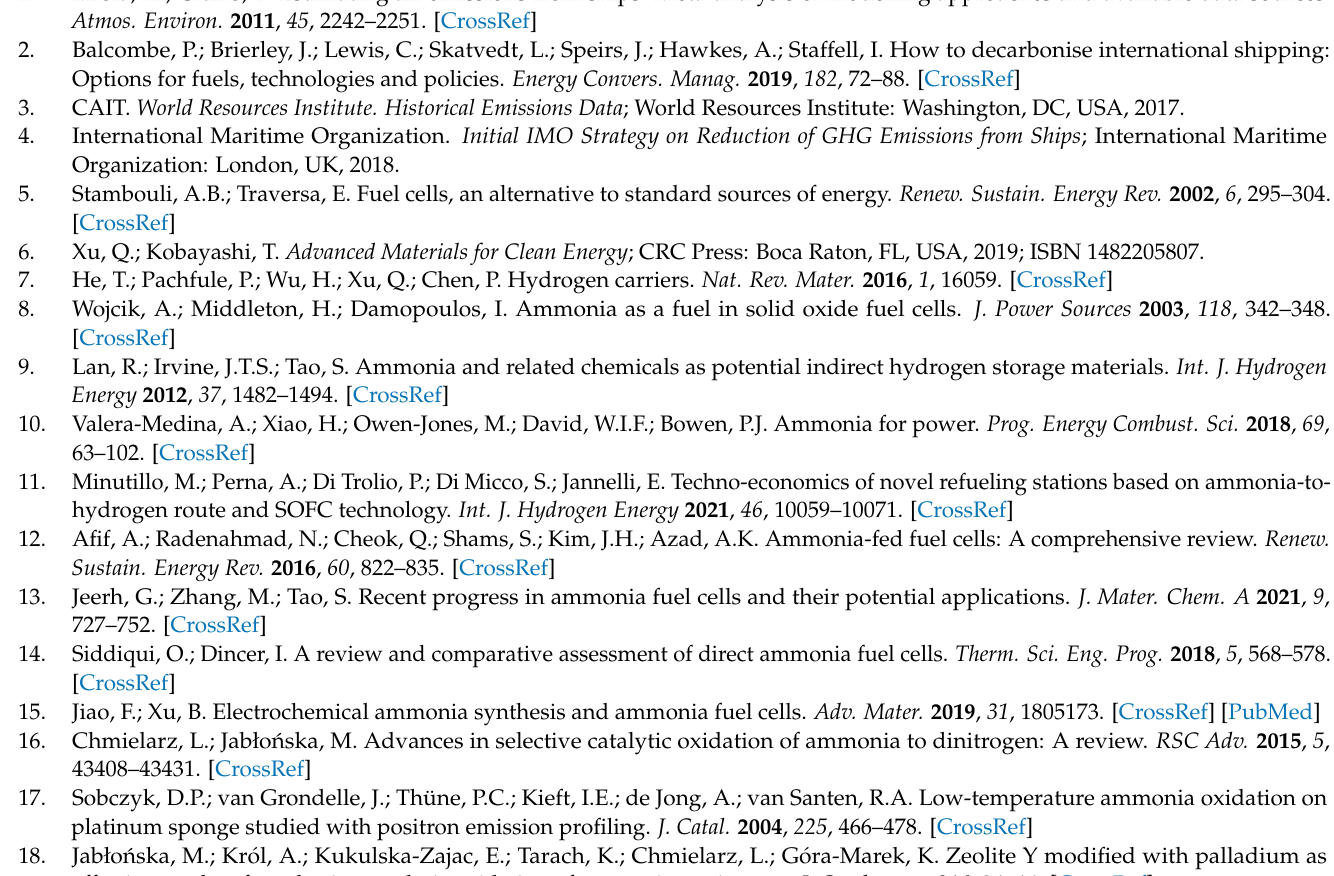
based catalysts; Figure S2: Powder XRD pattern of transition metal-based catalysts; Figure S3: TEM micrographs of the used catalysts with two different magnifications; Figure S4: TEM micrographs with interplanar distances and selected area electron beam diffraction images used for identification, Figure S5: Nitrogen sorption isotherm of Al 2 O 3 support; Figure S6: Nitrogen sorption isotherms of the used catalysts, Figure S7: Particle size distribution of different catalysts determined by TEM, Table S1: Specific surface area (BET method) of the used